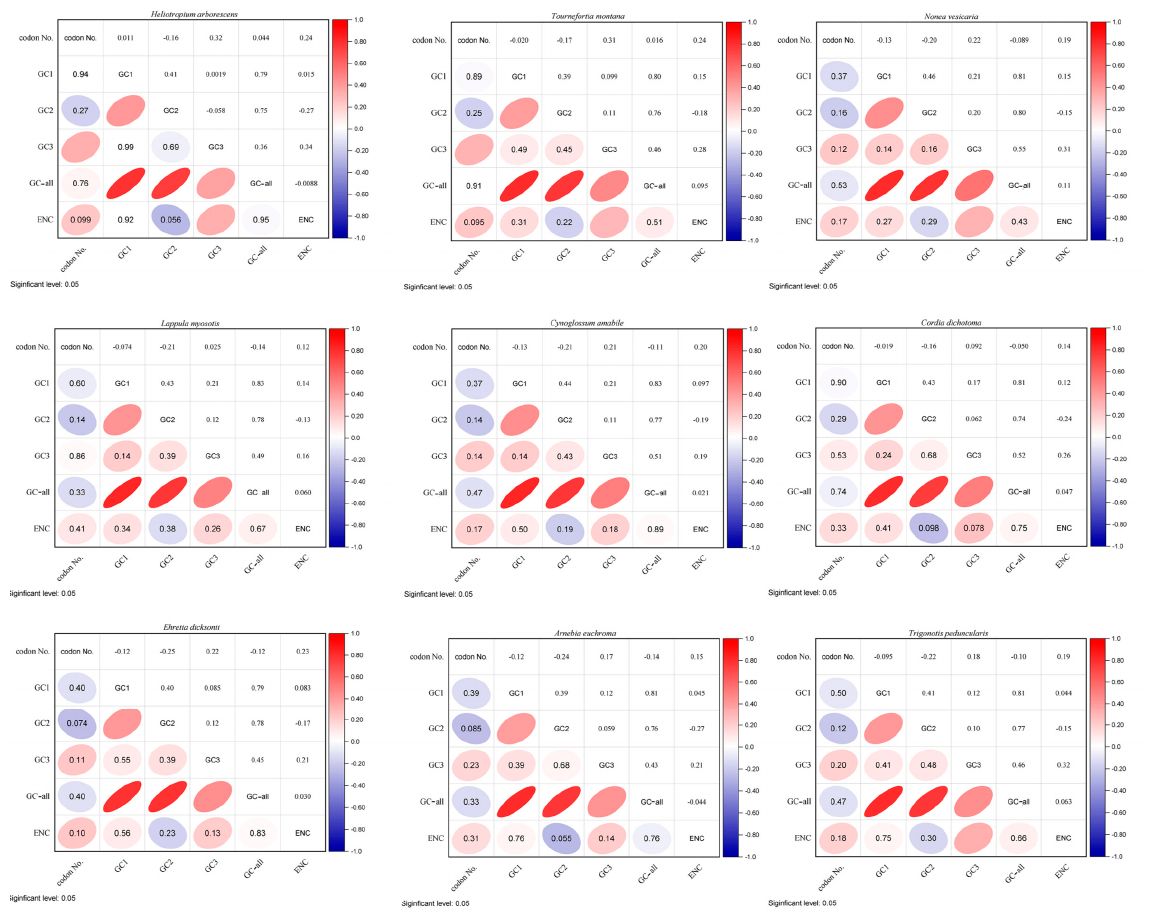
Figure 2. Correlation analysis of GC content, the number of codons, and ENC values. Numbers in the lower left corner circle: p value; numbers in the upper right corner: correlation coefficient. Only the red circle has no number, indicating that the p value is less than